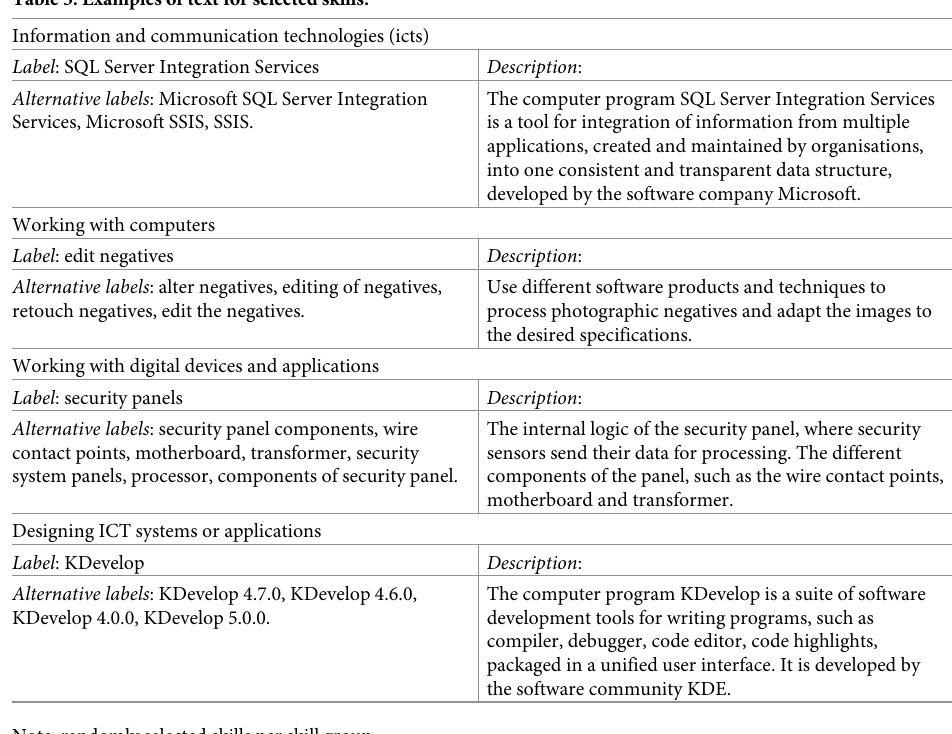
Table 3. Examples of text for selected